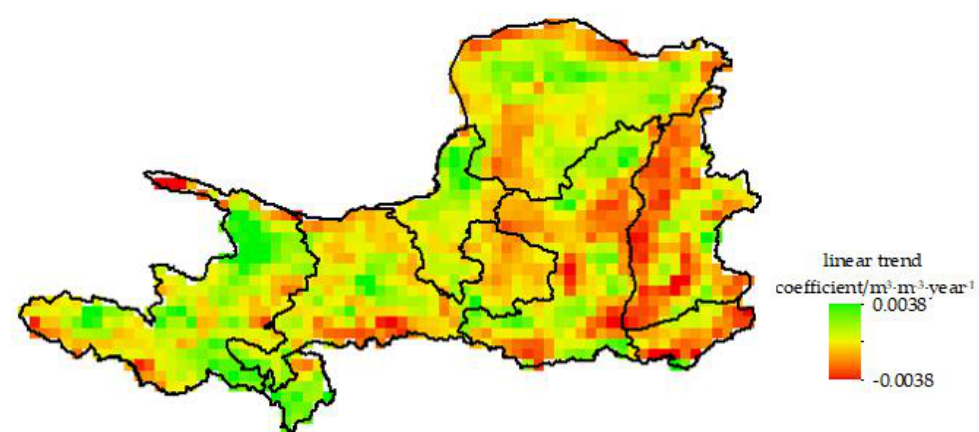
Figure 6. Linear trend distribution of annual average SM in the YRB from 2000 to 2015.